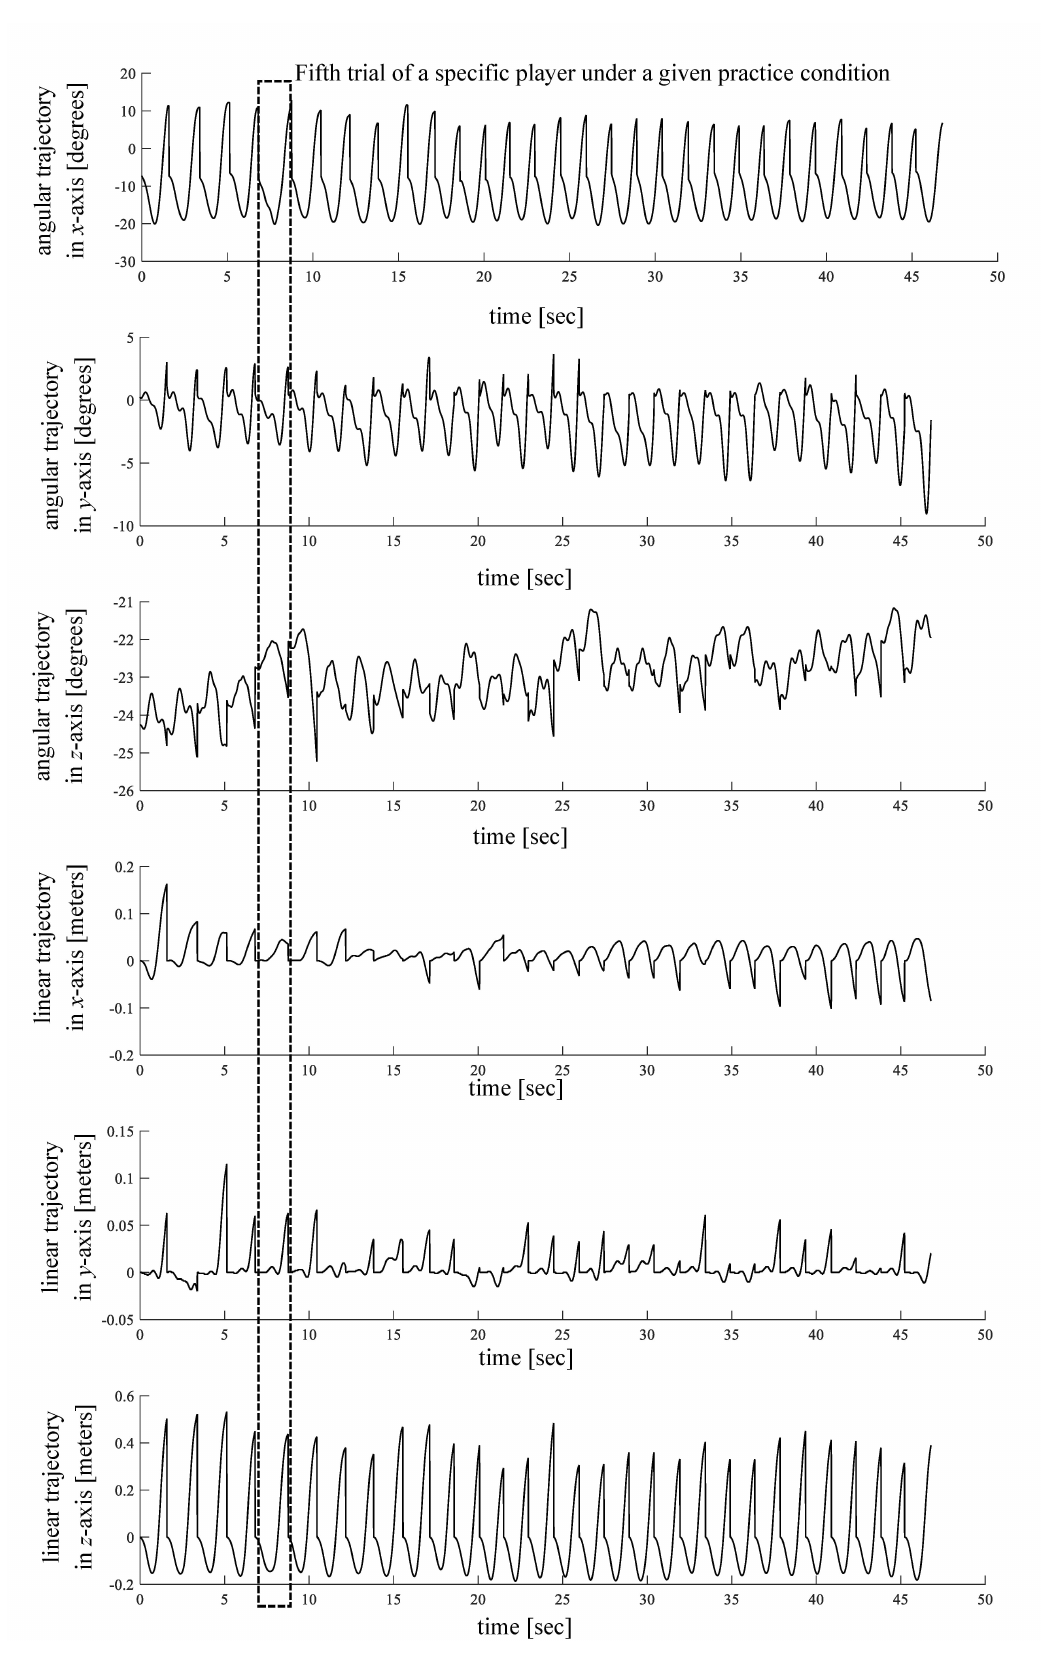
Fig. 3. Illustrative example of the time-series of golf putting